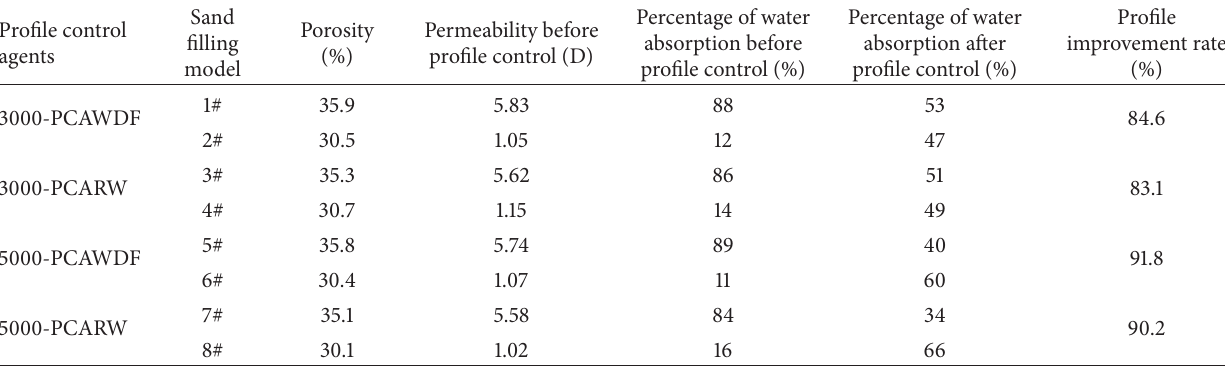
Table 3: The parameters and results of the core